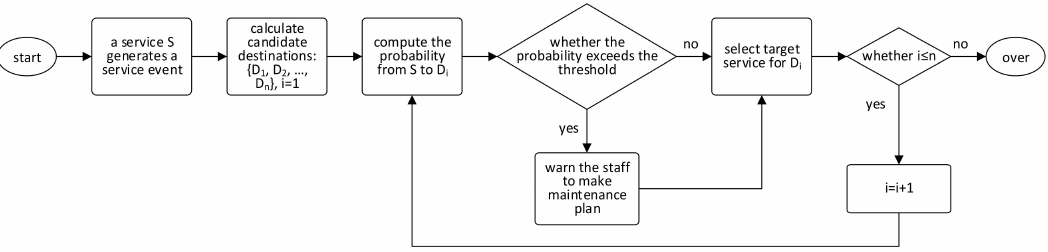
Figure 4. Workflow of our predictive industrial maintenance